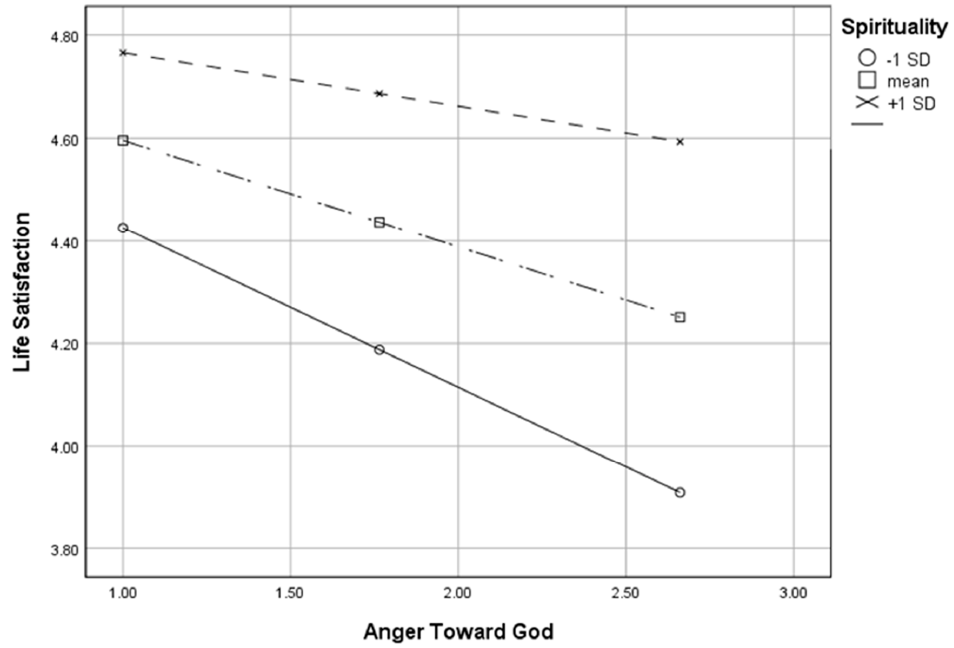
Table 3. Moderation analysis: Anger, spirituality, and well-being.